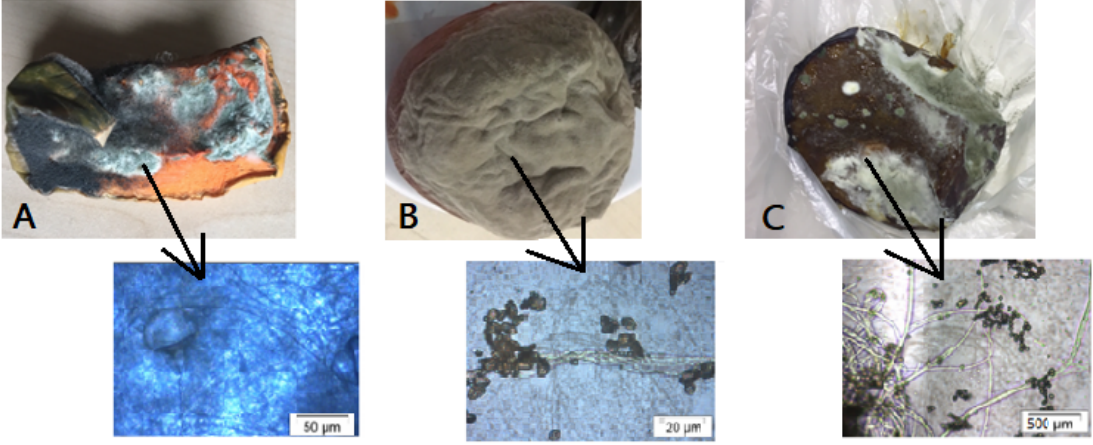
Figure 1. Spoilage fungi: ( A ) R. oryzae from pumpkins, ( B ) R. stolonifier from peaches, and ( C ) A. penicillioides form prunes.